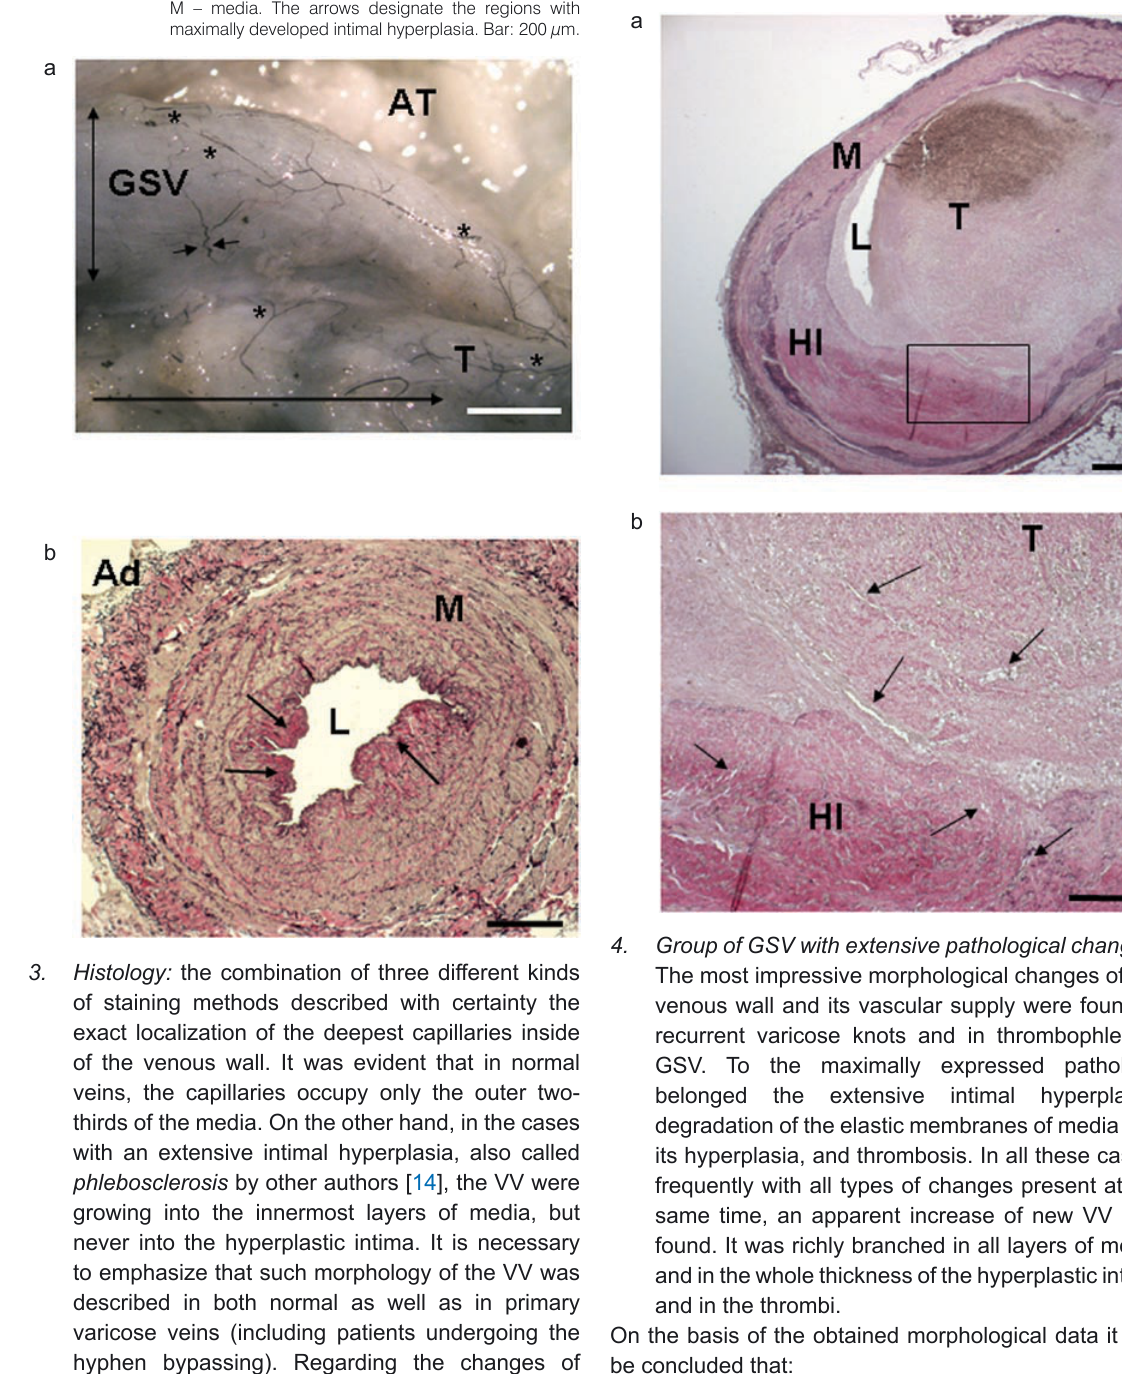
Figure 3. a. Microdissection of the stem of primary varicose GSV. VV are injected by India ink. In the adventitia and in the surrounding adipose tissue, small irregular venous dilatations (asterisks) and tortuosities (arrows) are apparent. The long arrow indicates the direction of the blood flow. Bar: 3 mm. b. Cross section of the stem of primary varicose GSV. Staining for elastin. Ad – adventitia, L – lumen, M – media. The arrows designate the regions with maximally developed intimal hyperplasia. Bar: 200 μm.